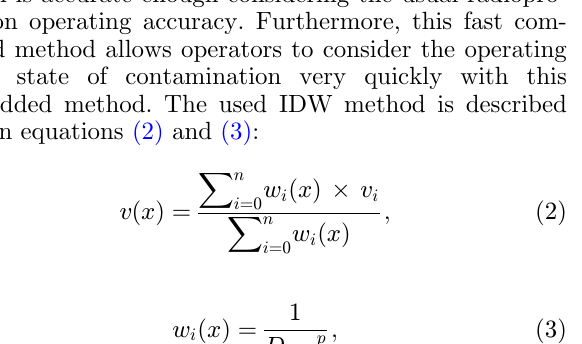
Fig. 7. Spectrum positioning management.